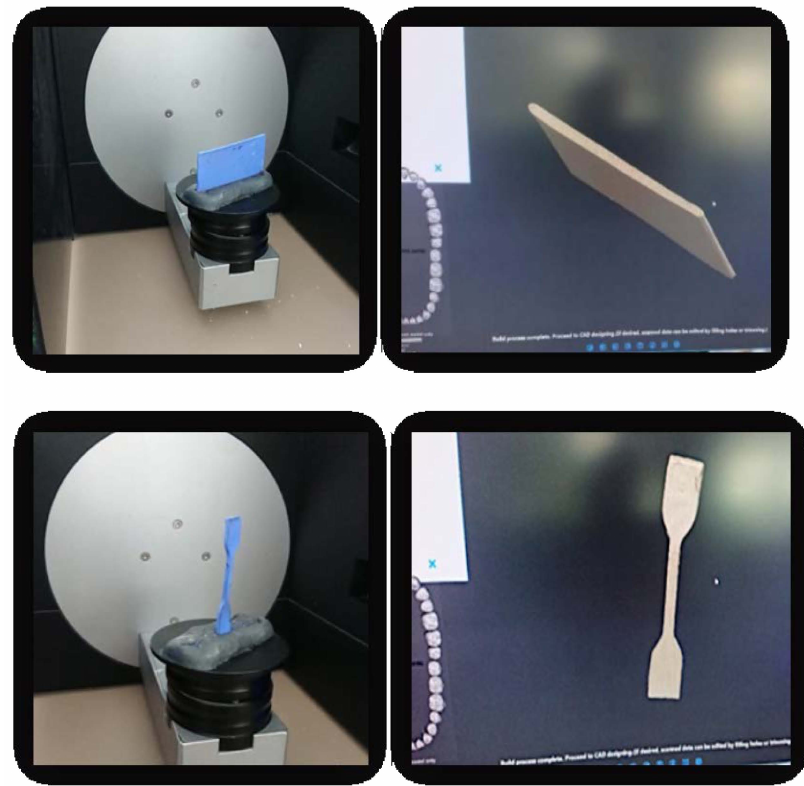
Figure 4. Wax patterns scanning.